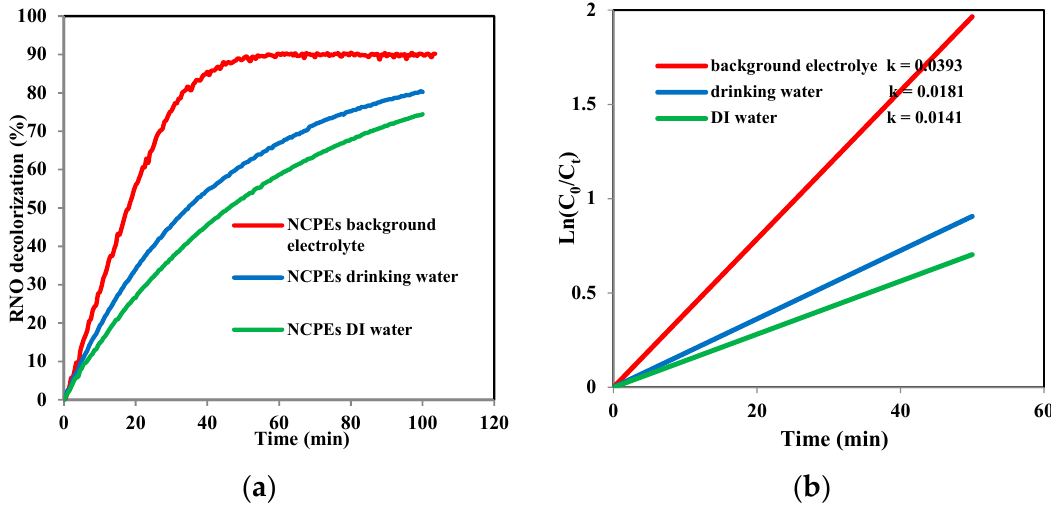
Figure 8. ( a ) RNO decolorization in 3D-NCPEs system using different solvents, ( b ) corresponding kinetic rate curves at 15 V.